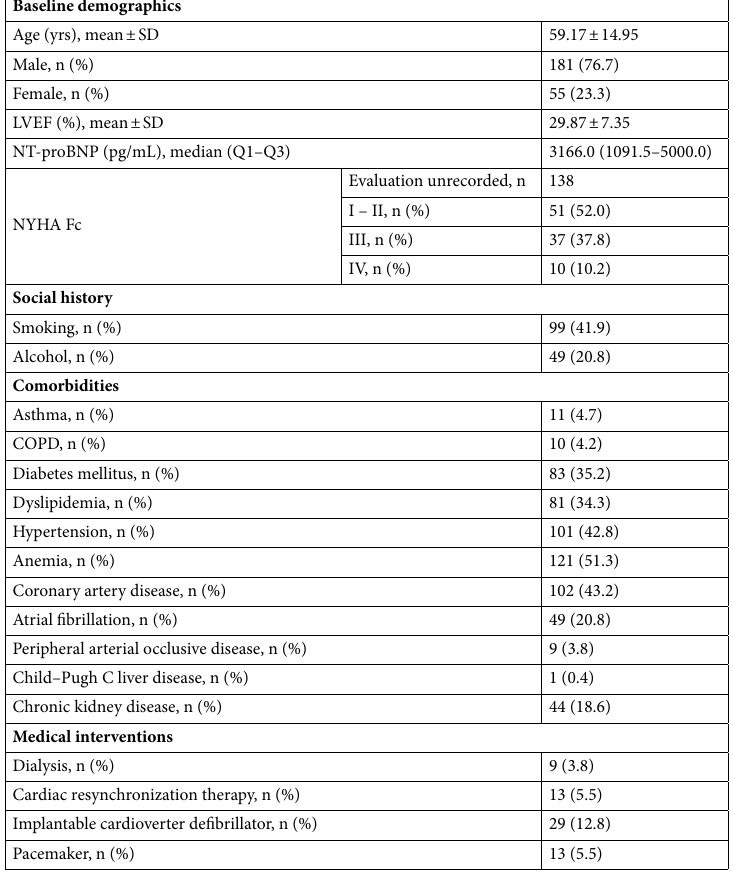
Table 2. Characteristics of patients in anemia treatment analysis ( n = 236). COPD chronic obstructive pulmonary disease, LVEF left ventricular ejection fraction, NT-proBNP N-terminal pro-B-type natriuretic peptide, NYHA Fc New York Heart Association functional